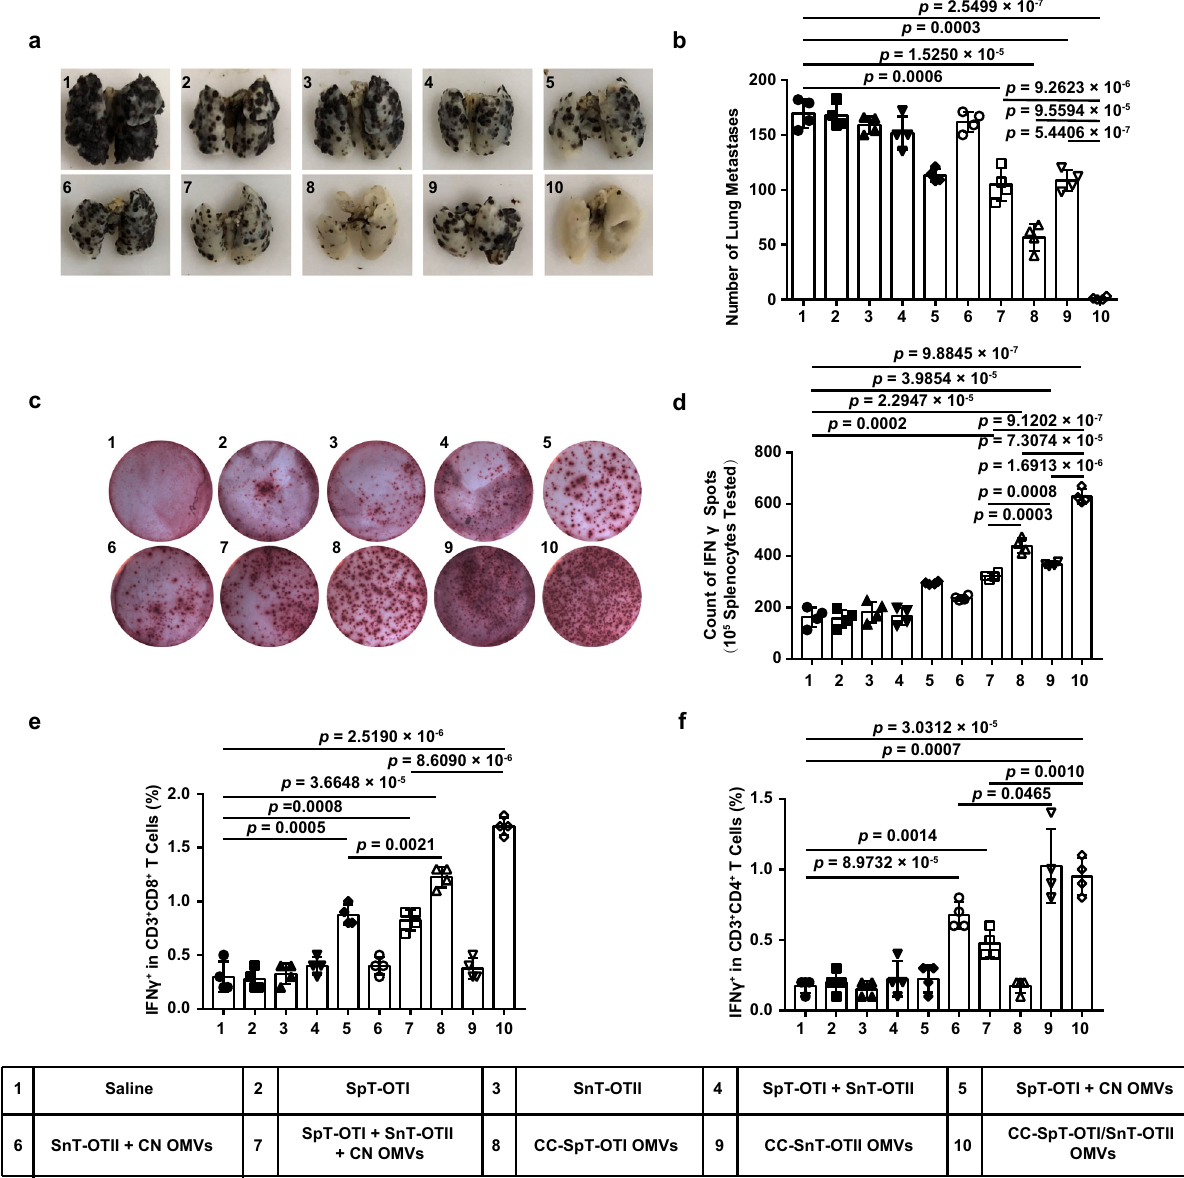
Fig. 5 Dual-tumor antigen (OVA 257 – 264 and OVA 223 – 339 ) display by catcher-decorated OMVs triggers CD4 + and CD8 + T-cell-mediated synthetic anti- tumor immunity. SpT-OTI and SnT-OTII were displayed either singly (CC-SpT-OTI OMVs or CC-SnT-OTII OMVs) or simultaneously (CC-SpT-OTI/SnT- OTII OMVs) by CC OMVs. Mixed formulations (SpT-OTI + CN OMVs, SnT-OTII + CN OMVs, and SpT-OTI + SnT-OTII + CN OMVs) were used as controls. OTI: OVA 257 – 264 , OTII: OVA 223 – 339 . a , b Lungs were collected on day 17 at the end of the treatment period and photographed ( a ); the tumor nodules were counted ( b ). c , d IFN γ secretion by splenocytes isolated from the various treatment groups was determined by the ELISPOT assay after re- stimulation of the cells with OVA 257 – 264 and OVA 223 – 339 ( c ). Quantitative data derived from the ELISPOT assays are shown in ( d ). e , f Flow cytometry analysis of IFN γ + cells in the CD3 + CD8 + T-cell subpopulation ( e ) or the CD3 + CD4 + T-cell subpopulation ( f ) in splenocytes re-stimulated with OVA 257 – 264 and OVA 223 – 339 antigens. The data ( b , d – f ) are shown as mean ± SD ( n = 4). Statistical analysis was performed by a two-tailed unpaired t test. Source data are provided as a Source Data fi response, as expected, was induced by CC-SpT-OTI/SnT-TRP2 these data indicate that the display and presentation of multiple OMVs (Fig. 6a, b). The analysis of IFN γ production and the levels antigens to CD8 + T cells can be realized using our platform. This of IFN γ + cytotoxic T lymphocytes showed that OVA 257 – 264 and strategy enables the coverage of complex and heterogeneous TRP2 180 – 188 were both successfully presented to T lymphocytes tumor antigens in vaccine design. when displayed on CC OMVs (groups 8 and 9; Fig. 6c – e); this effect was much stronger in the OMVs formulations than it was in the mixed formulations (groups 5 and 6, respectively). More Anti-tumor effects in a subcutaneous tumor model . The importantly, the CC OMVs displaying two antigens induced subcutaneous MC38 tumor model was adopted to evaluate the anti- more antigen-speci fi c T lymphocytes than those displaying a tumor immunity in the colon cancer model. Adpgk, a neoantigen in single antigen (Fig. 6c – e and Supplementary Fig. 19). Together, MC38 tumors, was labeled with SpT (SpT-Adpgk). SpT-Adpgk was